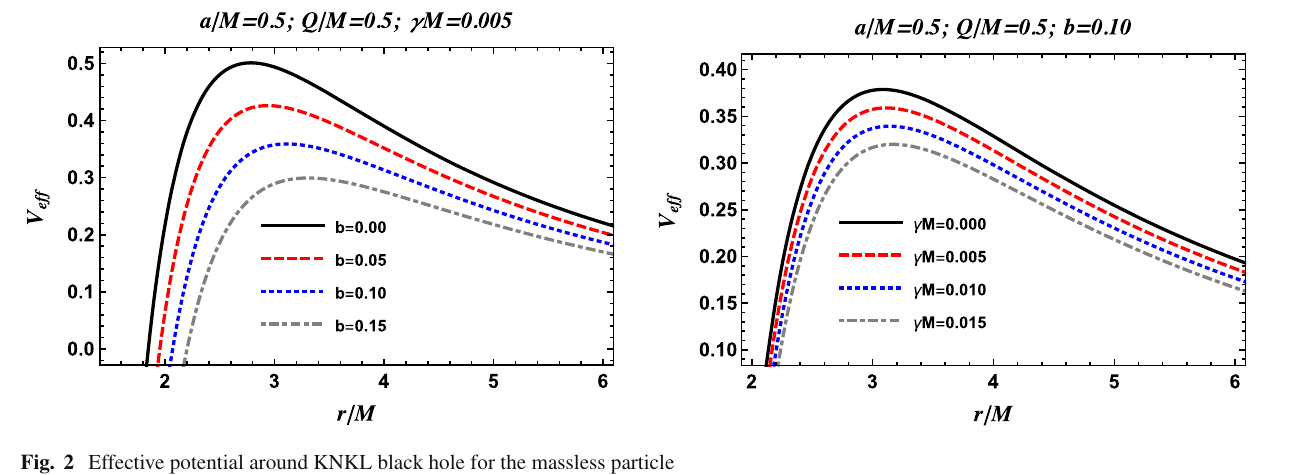
Fig. 2 Effective potential around KNKL black hole for the massless particle